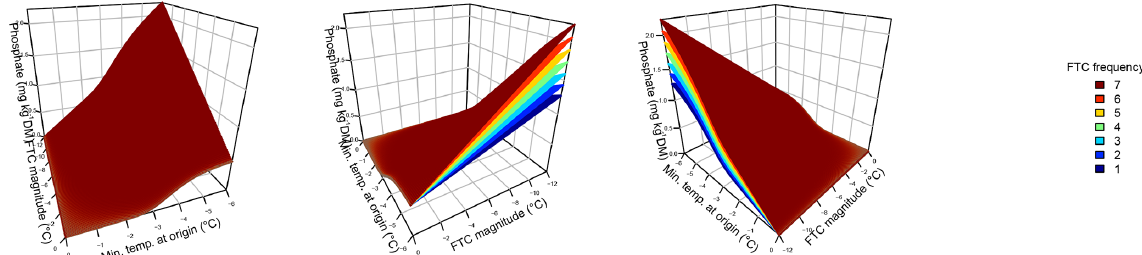
Figure 3. Phosphate concentrations depended on the three-fold interactive effects of winter climatic origin (expressed as long-term mean min- imum winter temperature at the origin), FTC magnitude (expressed as the minimum temperature experienced during the FTC manipulation and displayed for freezing temperatures), and FTC frequency during the FTC manipulation. FTC: freeze–thaw cycle. The four-dimensional representation is displayed from three different angles (see Supplement D for an animated version) and is based on the best model fit in the hierarchical regression analysis (model 15 in Table 5 with coefficients a 1 = 0 . 49455; a 2 = 0 . 01253; a 3 = 1 . 37580; a 4 = 0 . 00890; a 5 = 0 .